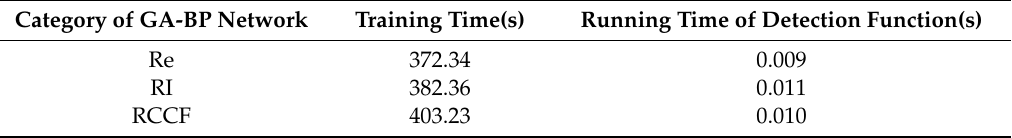
Table 9. The time required for the detection